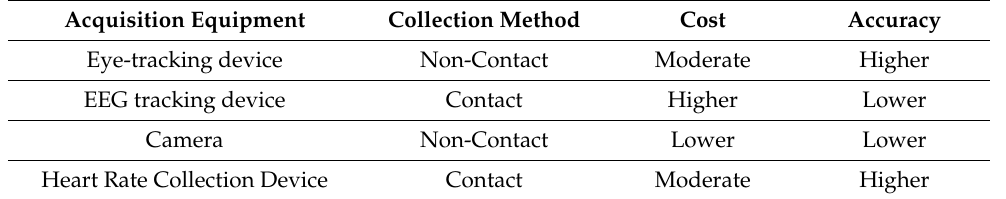
Table 1. Collection device comparison analysis table. Acquisition